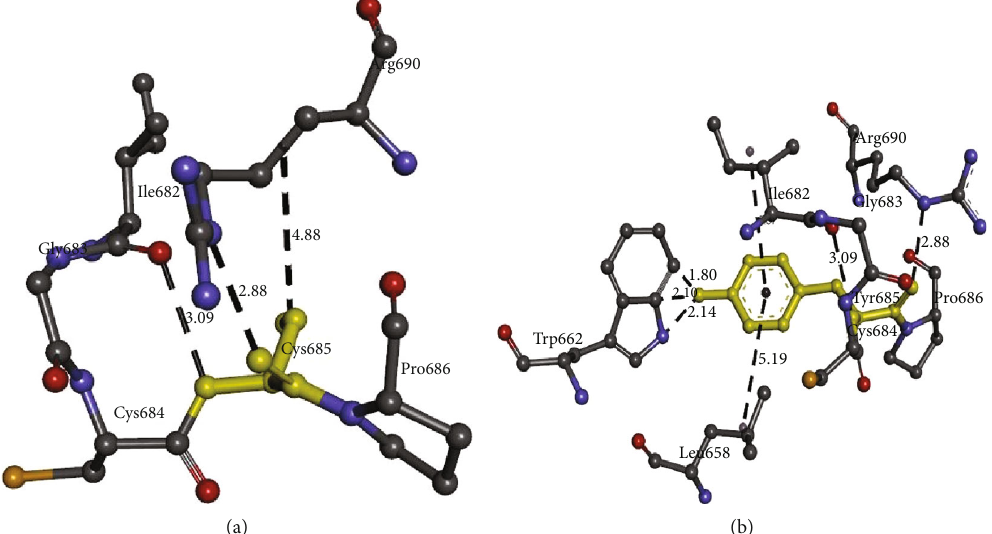
Figure 6: Molecular interactions of (a) Cys685 and (b) Tyr685 (highlighted in yellow) of the modeled ARAP3 protein with adjacent interacting residues. Table 4: Details of molecular interactions of Cys685 and Tyr685 of the modeled ARAP3 protein with adjacent interacting residues. S.